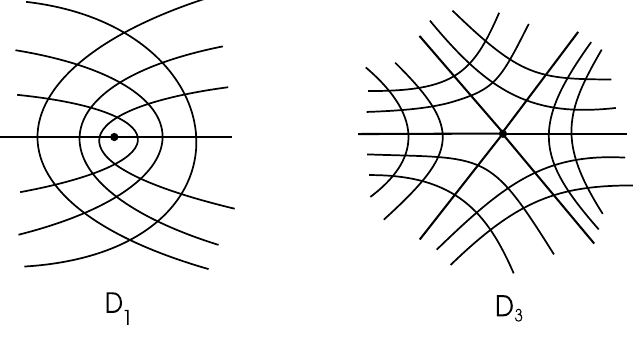
Fig. 5 – Darbouxian umbilic points D 1 and D 3